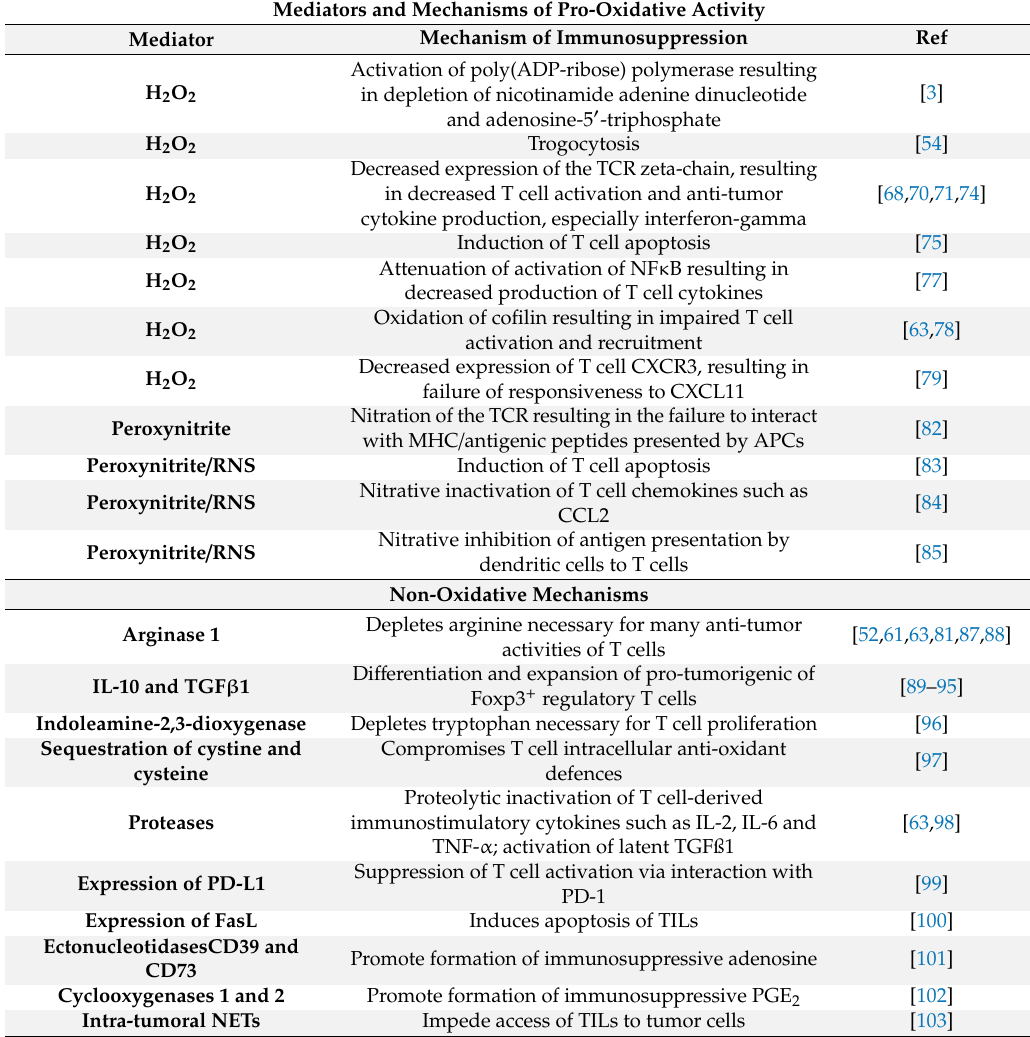
Table 3. Pro-oxidative and non-oxidative mechanisms of myeloid-derived suppressor cell (MDSC)-mediated T cell